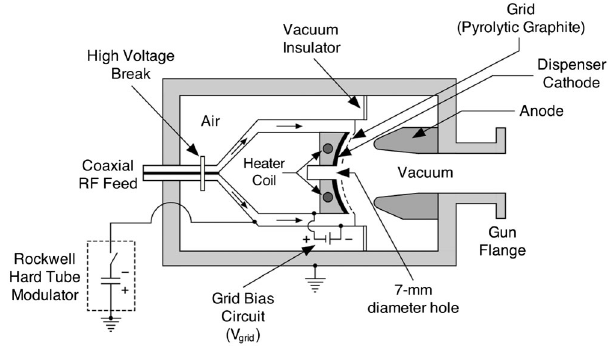
FIG. 1. Schematic diagram of the gridded thermionic electron